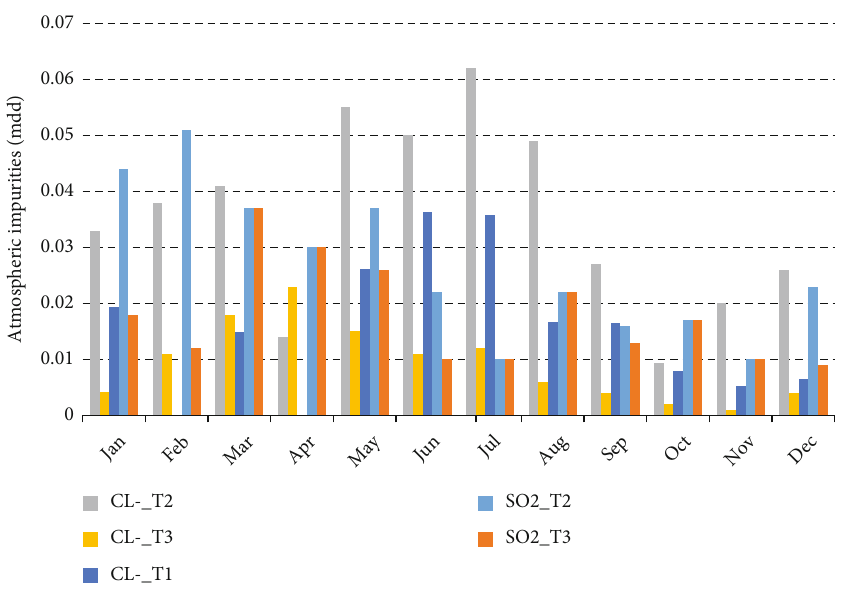
Figure 4: Atmospheric impurities at test sites. Table 4: Average deposition rate and classi fi cation of atmospheric pollutants. Site no.